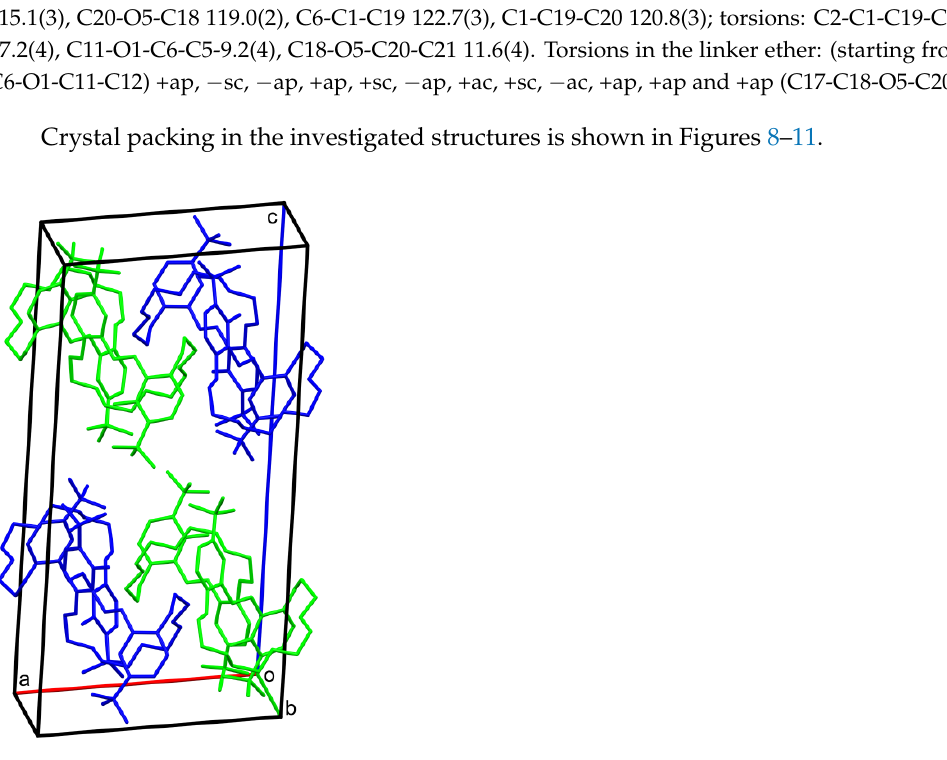
Figure 8. Crystal packing of t -Bu-19- o -OH , molecules are colored by symmetry equivalence. Hydrogen atoms are omitted.